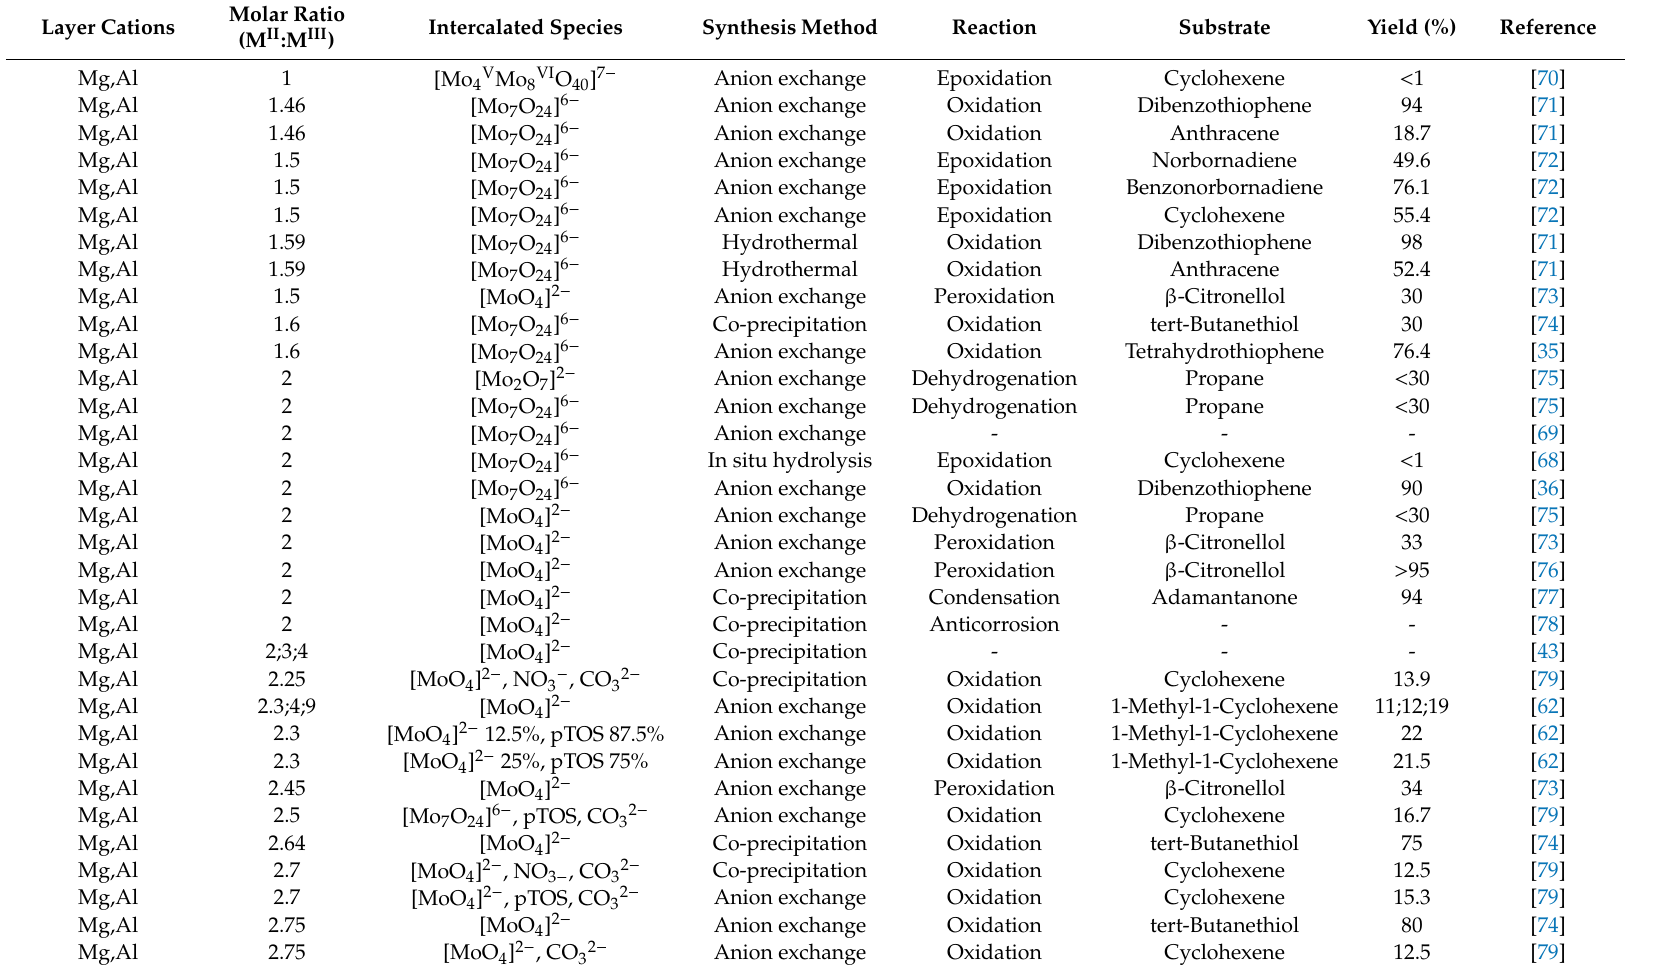
Table 6. Summary of LDH with intercalated molybdenum-based